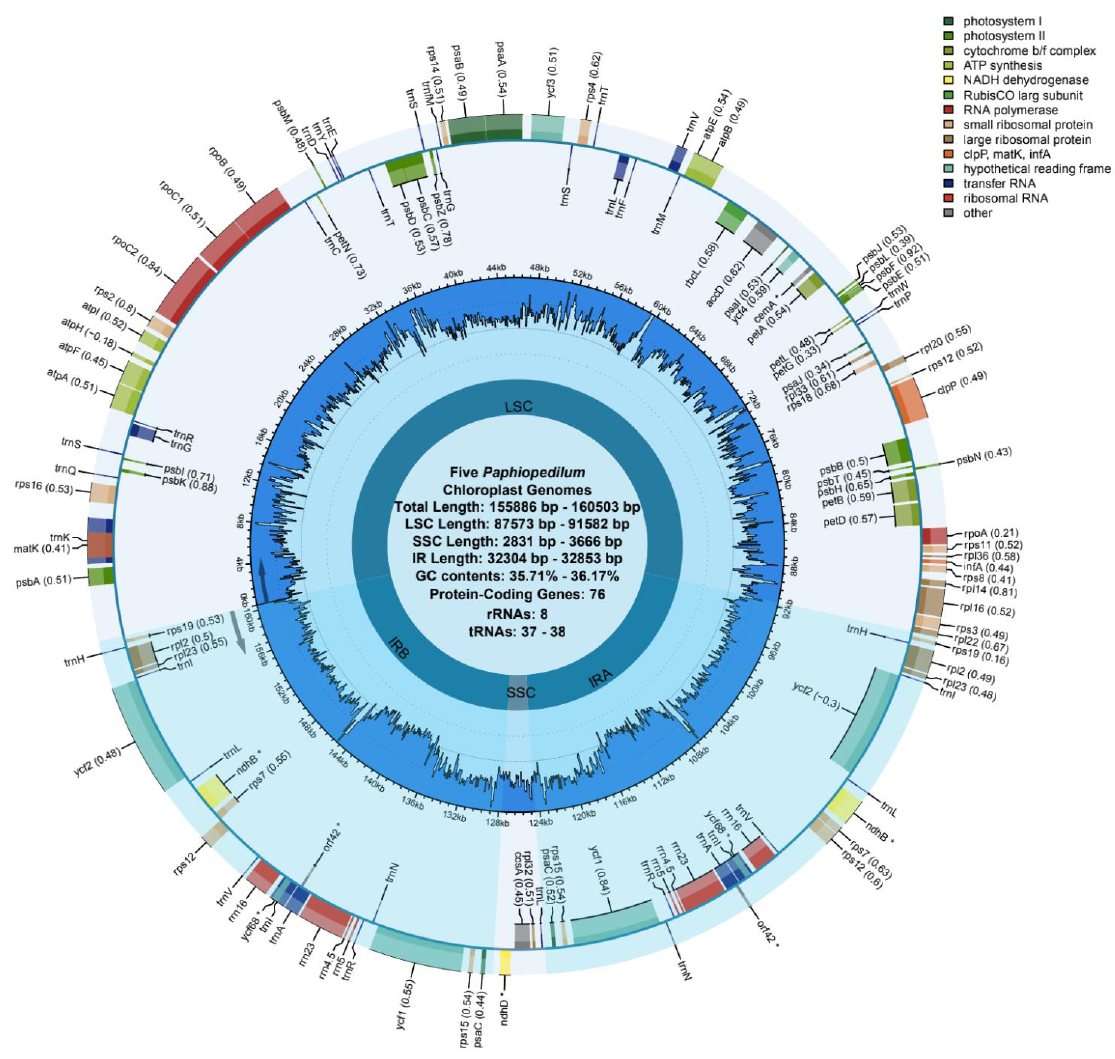
Figure 1. The whole chloroplast genome circle map of the five Paphiopedilum species. The gene names and their codon usage bias are shown on the outermost layer. Directed by arrow, the outside genes are transcribed clockwise, the inner genes are transcribed counter − clockwise, respectively. The gene GC content is plotted in the second circle, depicted in dark blue. The symbol “*” indicated that the pseudogenes in these chloroplast genomes.